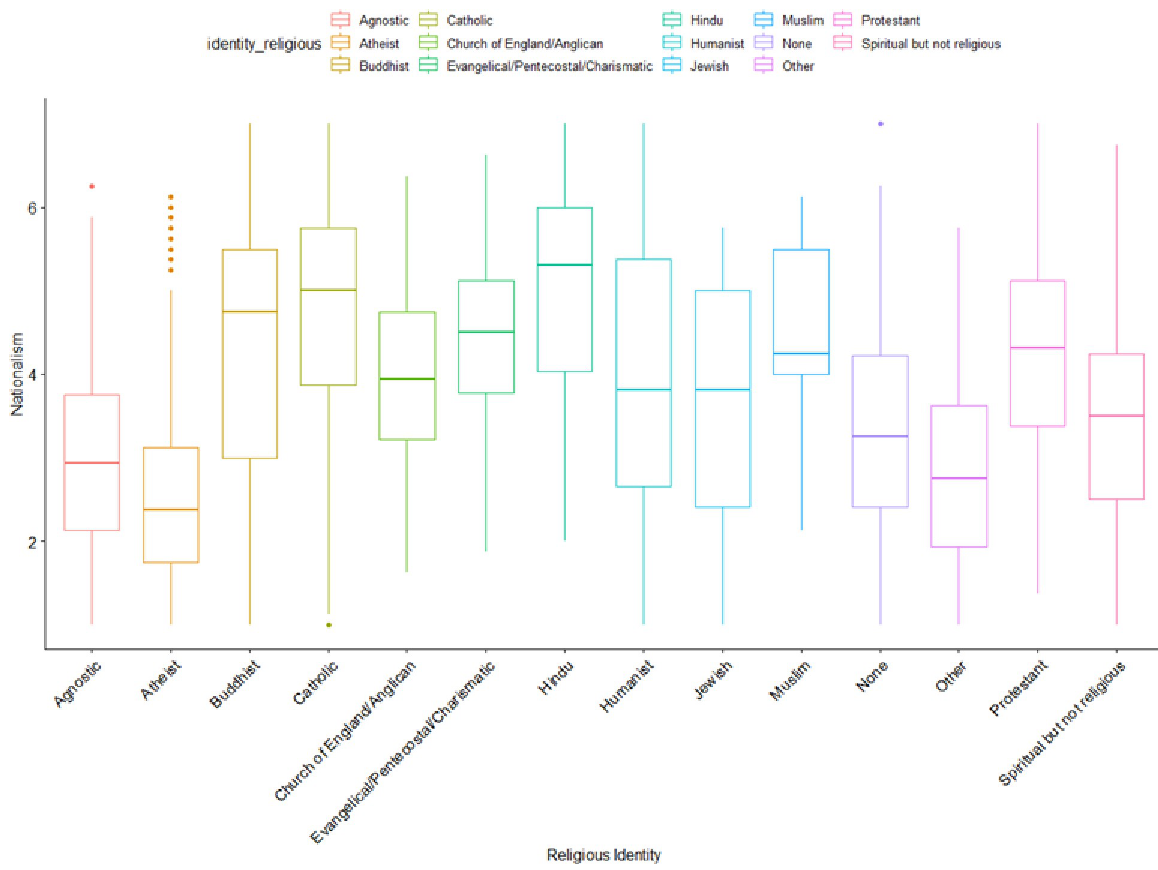
Fig 7. Distributions of nationalism by religious